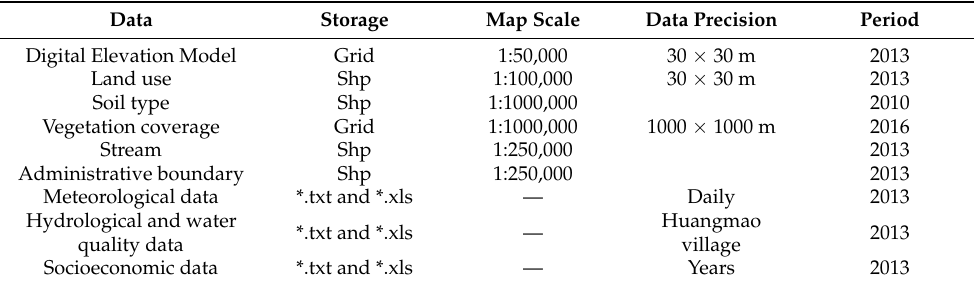
Table 2. Data used in the current research.